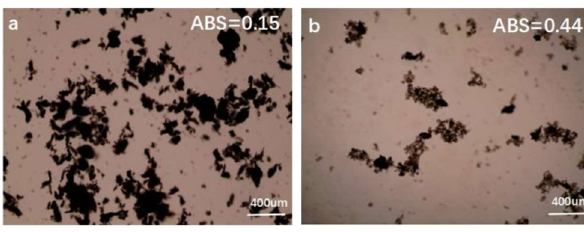
Figure 2: Dispersion state of GO ( a ) and TEA - GO ( b ) in pore solution [ 57 ] .